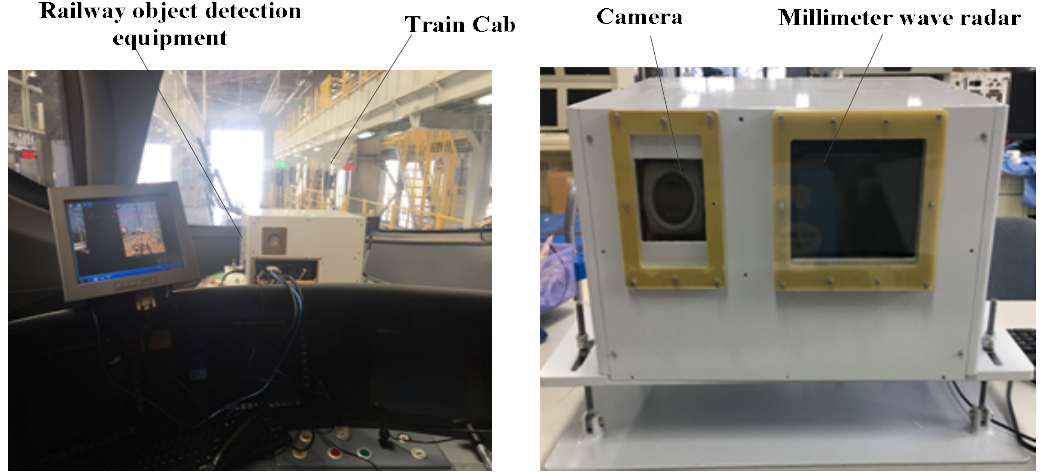
Figure 1. Principle prototype of our equipment.